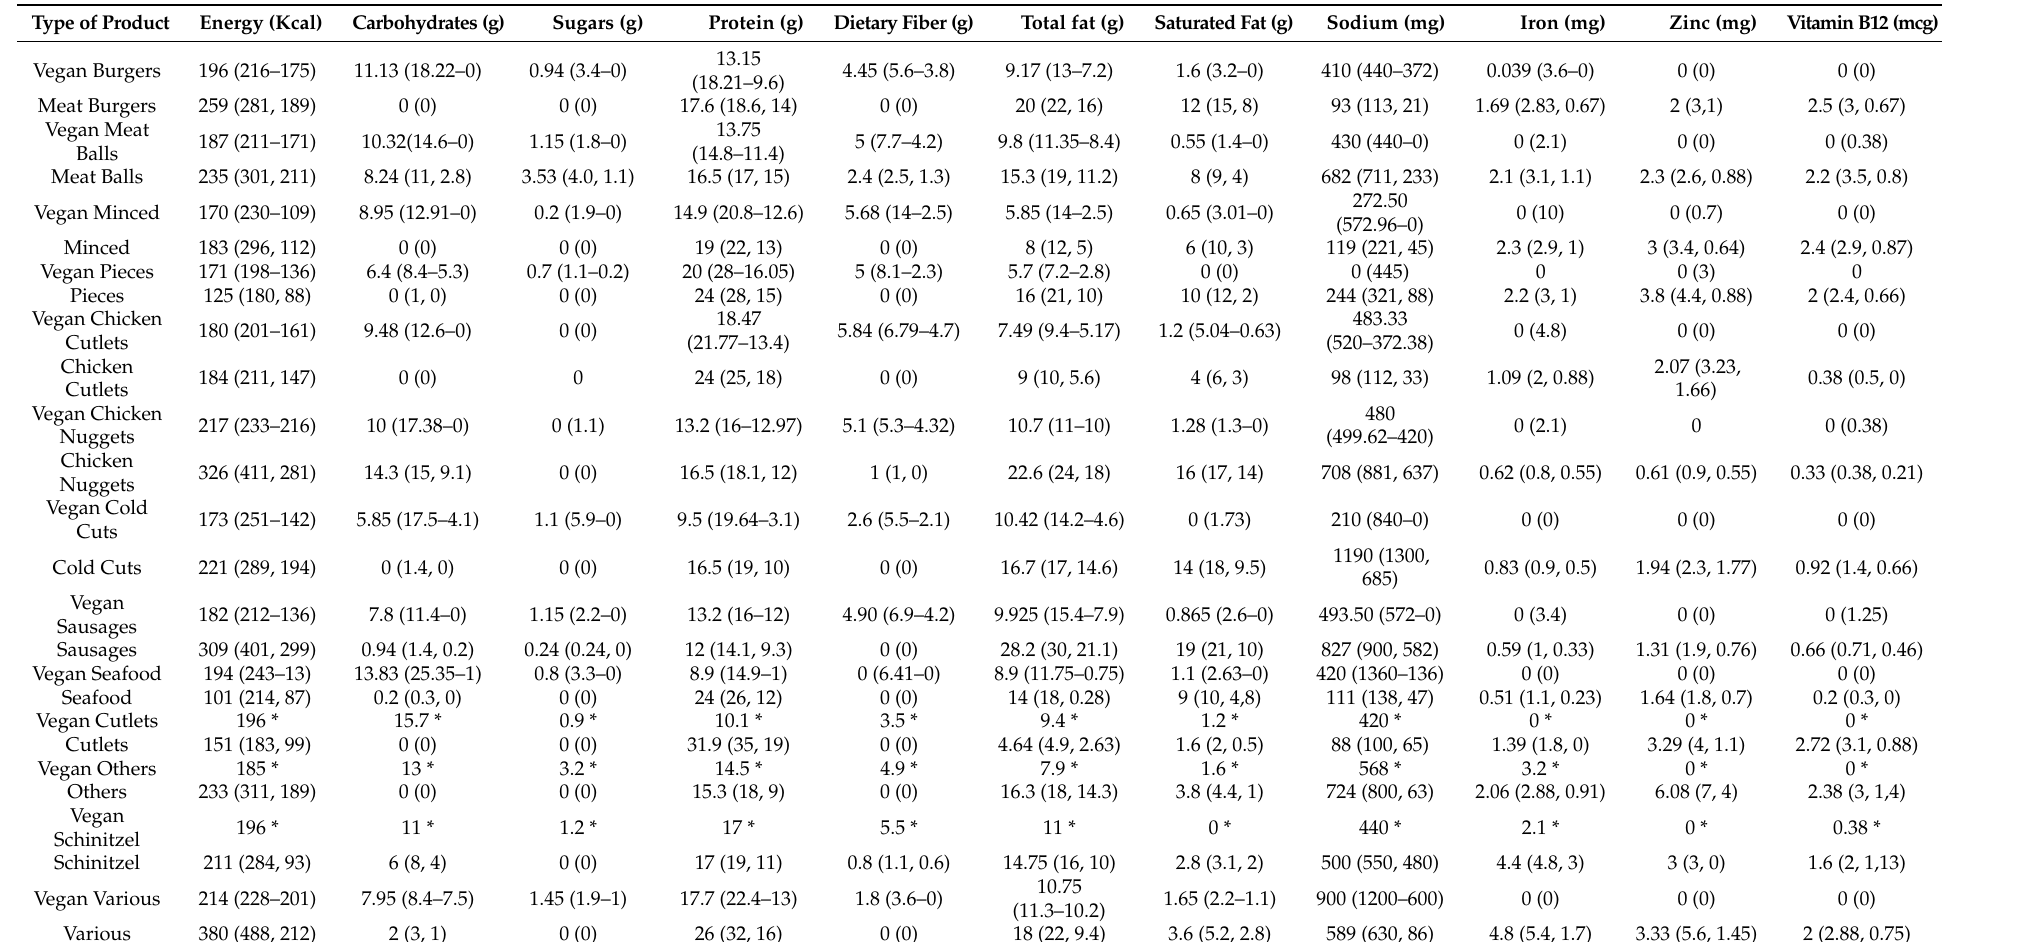
Table 2. Nutritional composition of meat products and their vegan substitutes with their medians, maximum and minimum values in 100 g of the